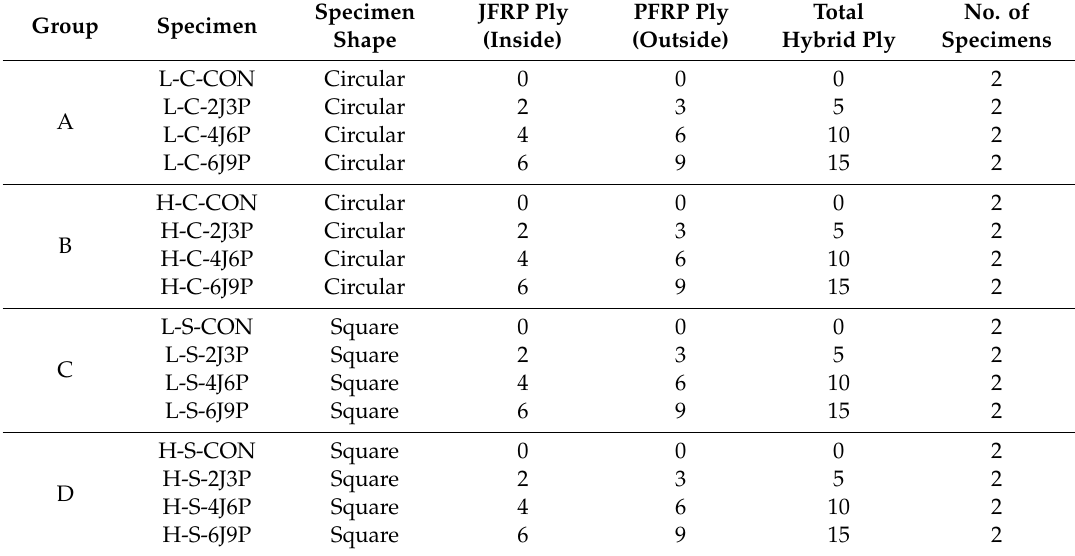
Table 1. Details of test